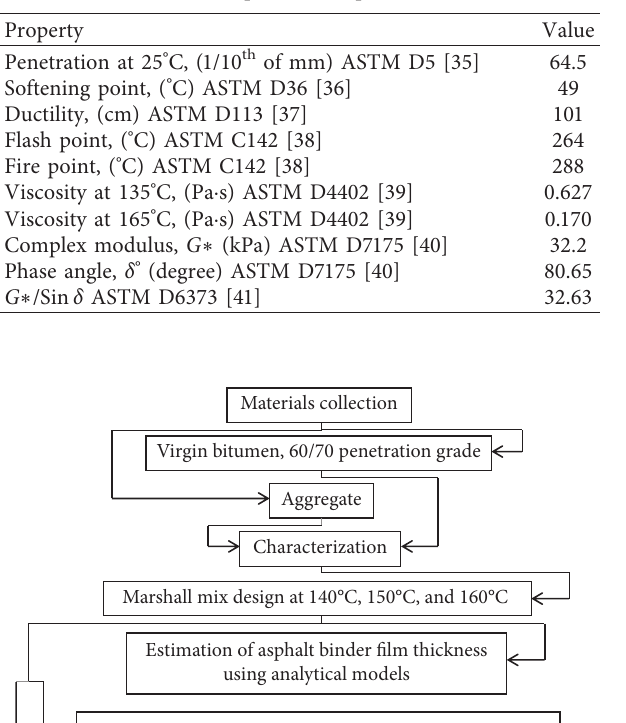
Table 6: Properties of asphalt binder.